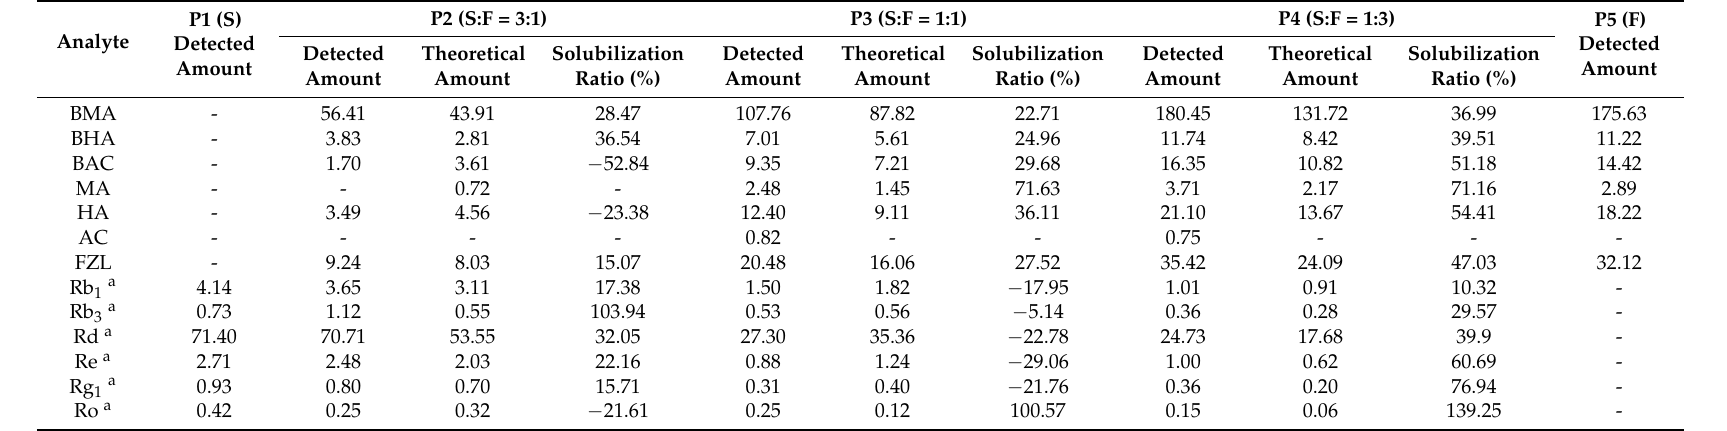
Table 6. The contents and solubilization ratios of 13 analytes by UPLC-QQQ-MS